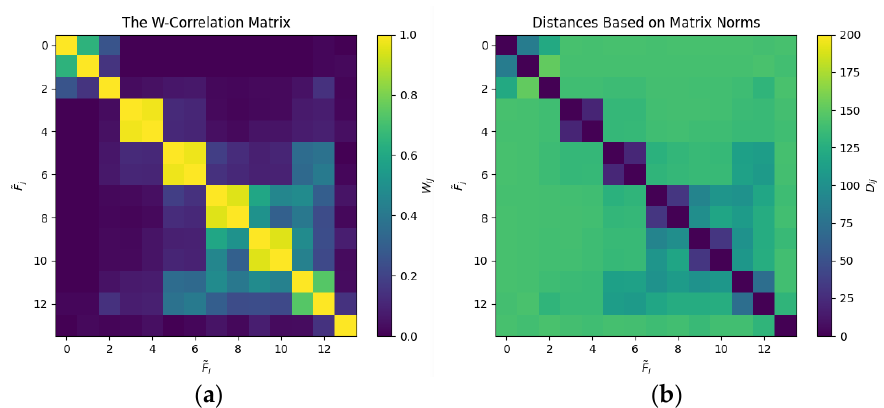
Figure 8. Matrices of distance between the principal components: ( a ) w-Correlation Matrix of distances between pairs of principal components; ( b ) matrix of Distances between pairs of principal components based on the Matrix Norm.